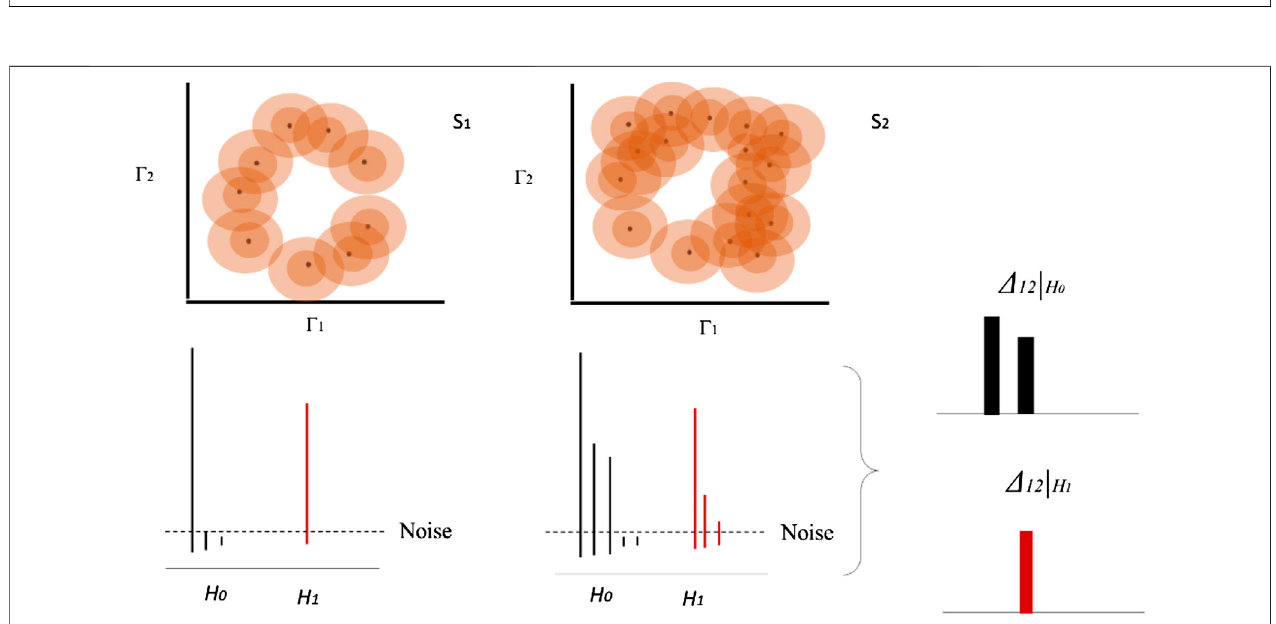
FIGURE 3 | Homology group and bar diagram for two different datasets based on example in Figure 1 . Each concentric circle on each data point represents a distancefunction d K .ForS1,thepersistentdiagramdeliversahomologygroupH0,thatis,agroupwithgenus (cid:2) 1.ForS2,theincreaseinthenumberofpointsallowsthe de fi nition of a homology group H1, that is, a surface with connected points. On the left, we schematically represent the difference between both persistent diagrams.